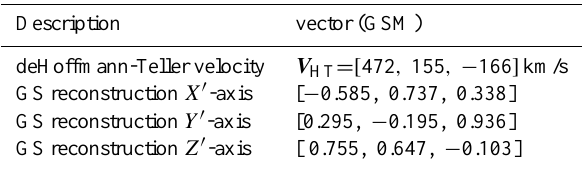
Table 1. The coordinate axes and the velocity of the GS